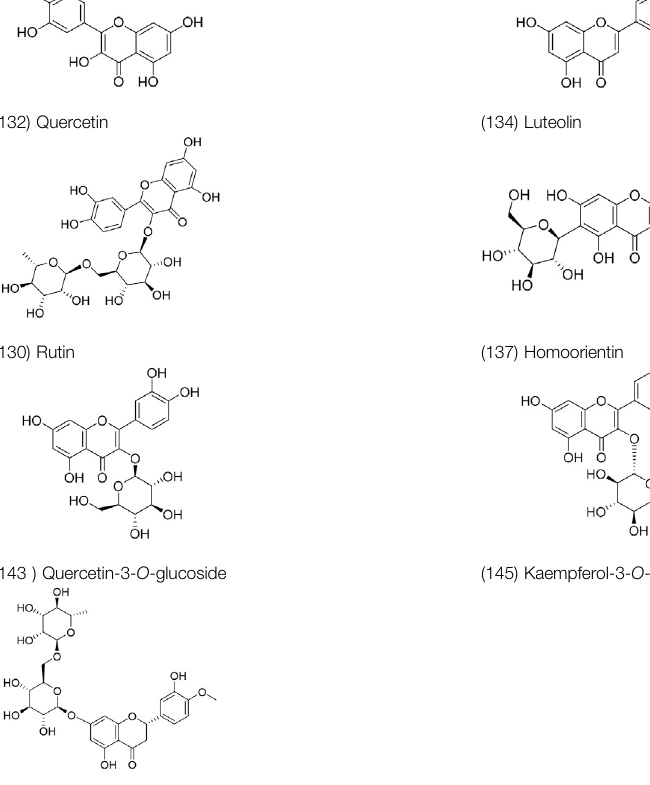
TABLE 8 | Chemical structures of fl avonoids isolated from